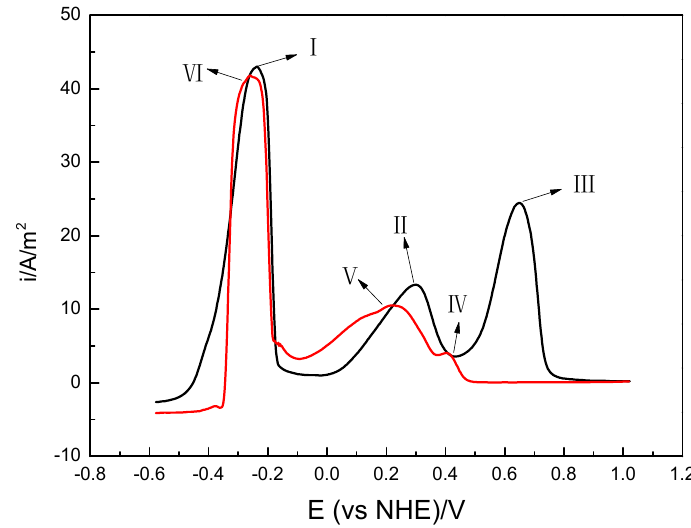
Figure 3. Cyclic Voltammetry plot of gold electrode in Bi intensification cyanide system.